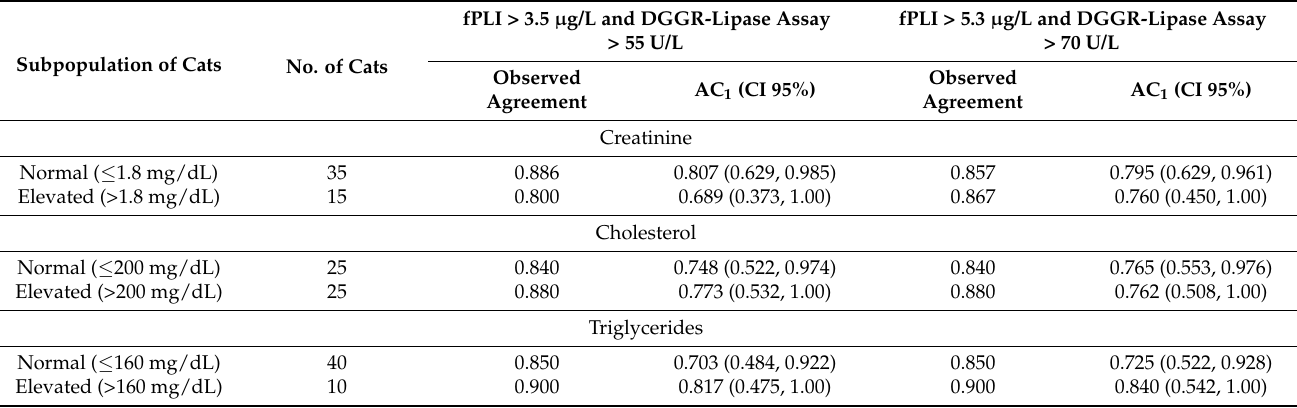
Table 2. Chance-corrected agreement (expressed as Gwet’s AC 1 coefficient with the 95% confidence interval [CI 95%]) between feline pancreatic lipase immunoreactivity (fPLI) assay and DGGR-lipase assay at optimal cut-off values in subpopulations of